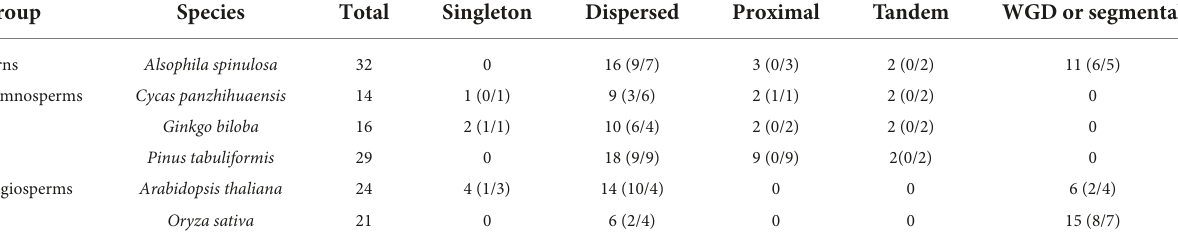
TABLE 1 Numbers of TCP genes from different origins as classified by duplicate gene classifier in six representative euphyllophytes genomes.